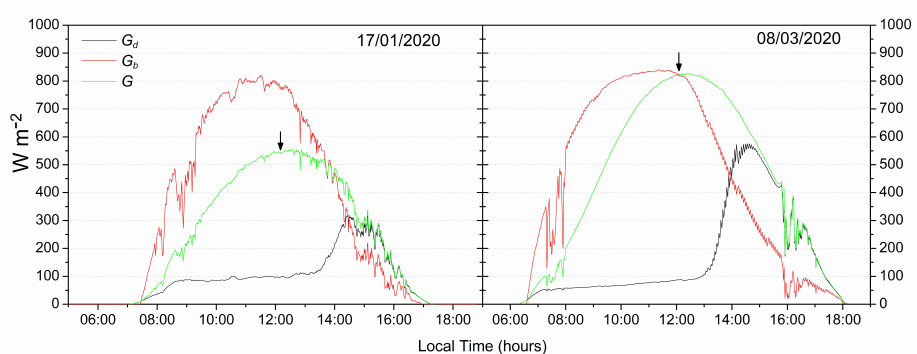
Figure 7. Diurnal evolution of global ( G ), diffuse ( G d ), and direct ( G b ) irradiances for the two days selected to analyze the soiling effect on the PV power production. The arrows mark the selected